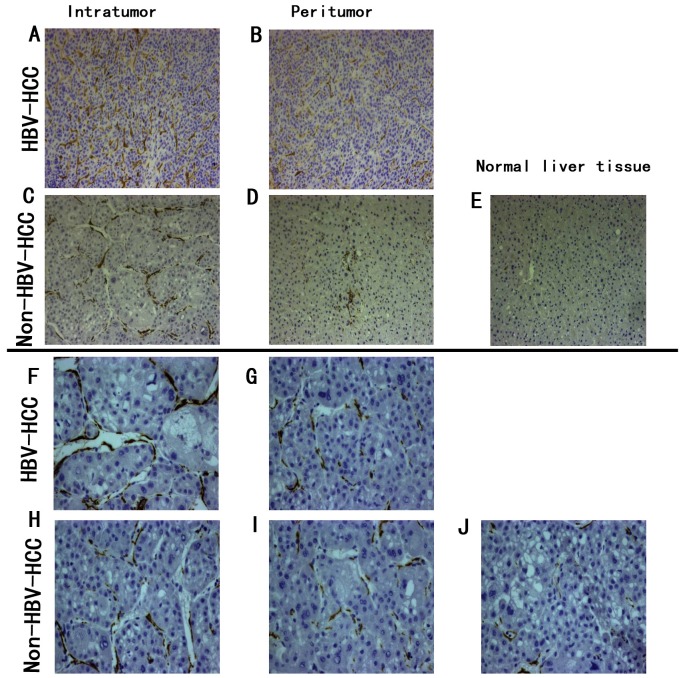
In situ staining shows IL-17 and IFN-γ expression in HBV-related and non- HBV-related HCC tumors.(A–E) IL-17-producing cells were stained as diffuse tan or brown particles in immunohistological sections. (A)Tissue from HBV-related HCC, and (B)paired para-cancerous tissues. (C)Tissue from non- HBV-related HCC, and (D)paired para-cancerous tissues; (E)tissue from normal, healthy liver. (F–J)IFN-γ-producing cells were also stained as brown particles in immunohistological sections. (F)Tissue from the non-HBV-related HCC, and (G)paired para-cancerous tissues; (H)tissue from HBV-related HCC, and (I)paired para-cancerous tissues; (J)tissue from normal, healthy liver.